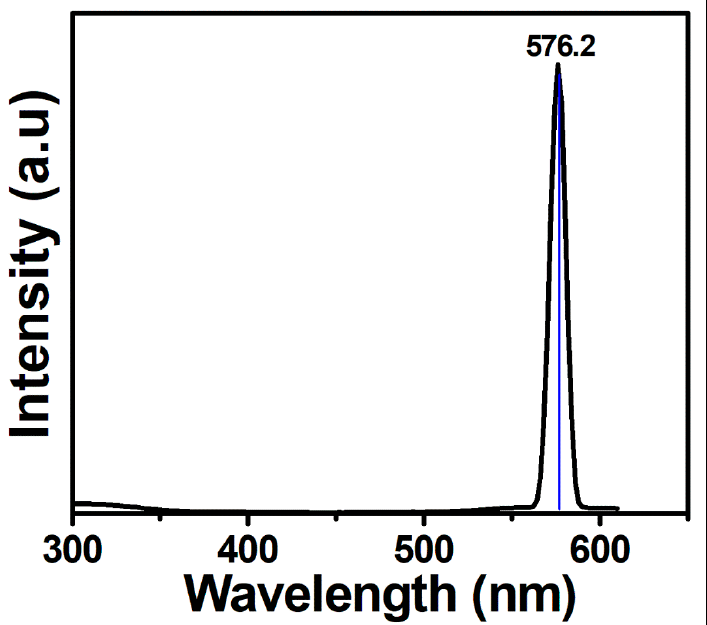
Figure 6. PL spectrum of greenly synthesized Ni/NiO NPs using leaves extract of Gymnema sylvestre .